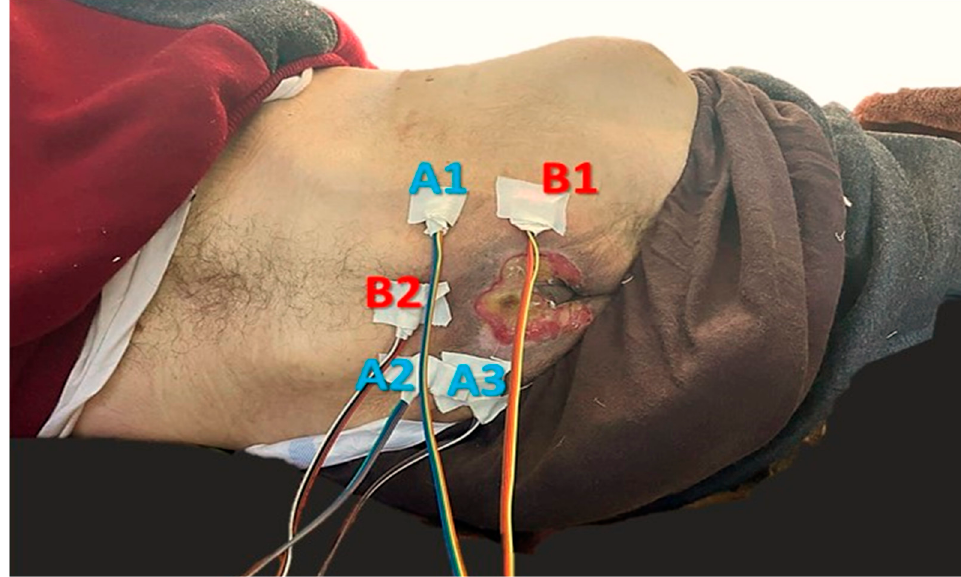
Figure 13. Sensors’ locations of sacral ulcer subject.